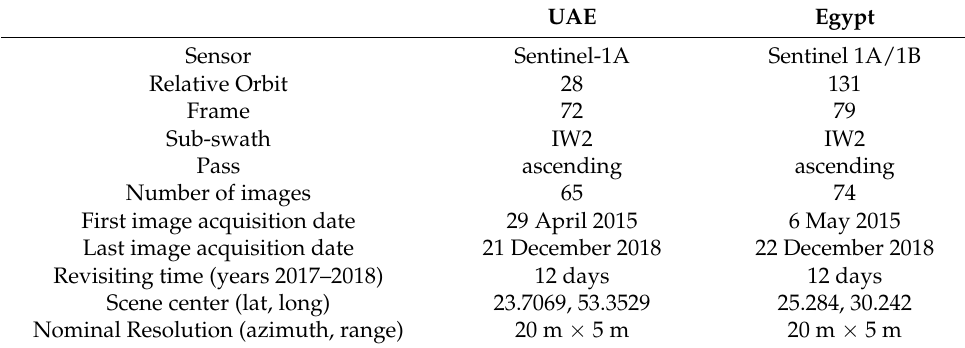
Table 1. Information related to Synthetic Aperture Radar (SAR) imagery collected for the United Arab Emirates (UAE) and Egypt use